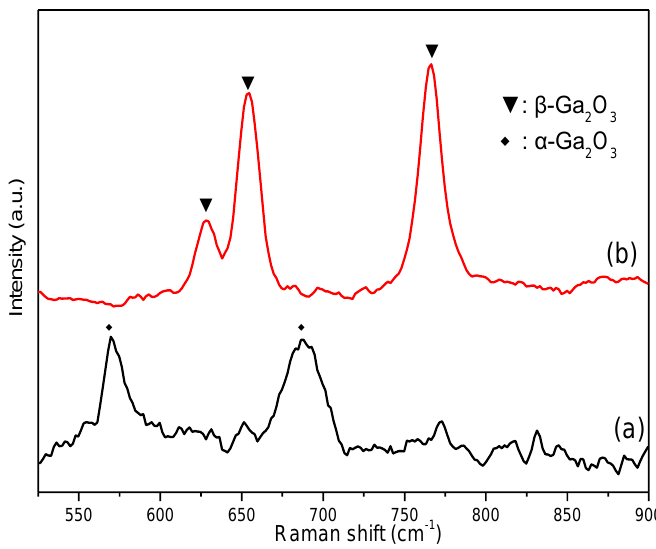
Figure 1. Raman spectra of Ga 2 O 3 from the GaOOH precursor calcined at ( a ) 600 °C and ( b ) 700 °C. Previous X-ray diffraction (XRD) results show that the phase composition of the GaOOH precursor and its calcined product are α-GaOOH (JCPDS No. 06-0180) and β-Ga 2 O 3 (JCPDS No. 41-1103), respectively [25]. The average crystallite size of β-Ga 2 O 3 sample is about 27.3 nm by the